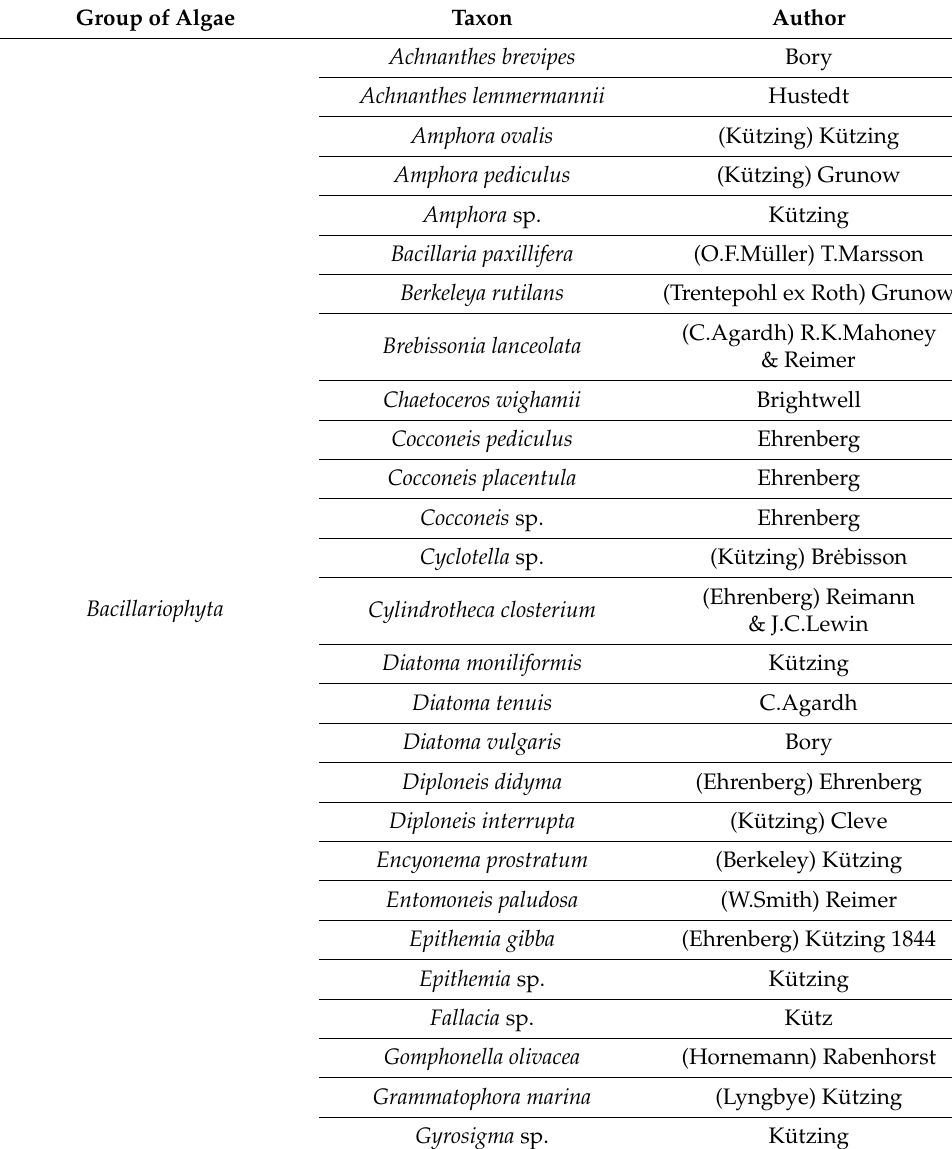
Table A1. List of taxa identified in the material